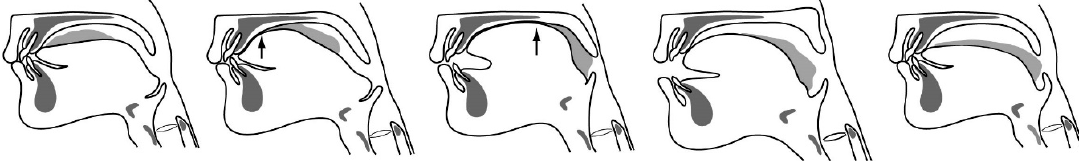
Figure 3. Schematic images of stage II transport. The tongue squeezes the bolus backward along the palate, through the fauces, and into the pharynx. The bolus head reaches the valleculae while food processing continues.